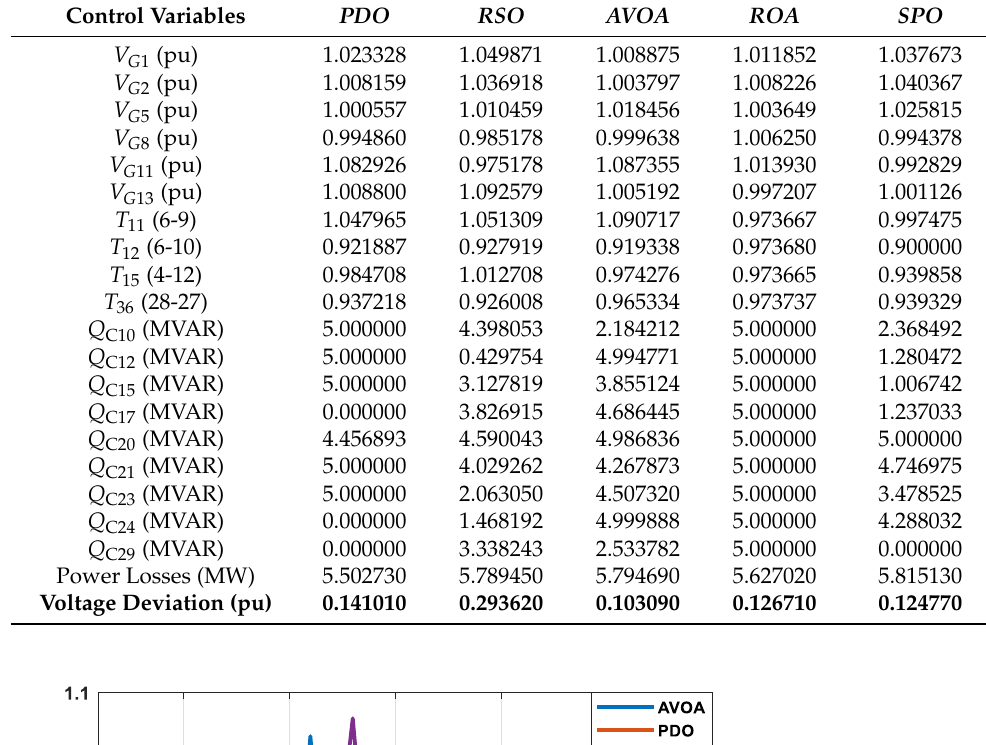
Table 6. Optimal IEEE-30 bus test system control variables for curtailment VD.